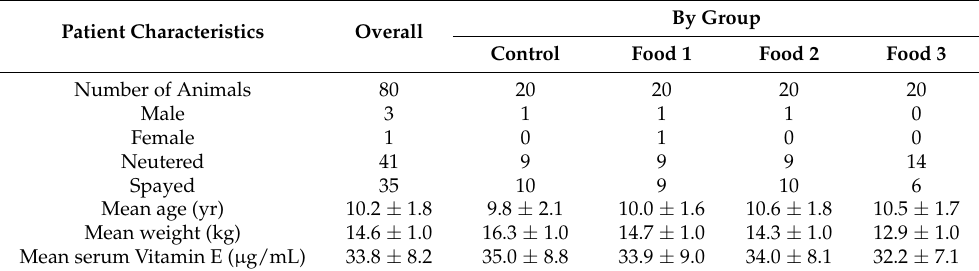
Table 1. Patient characteristics at the study start for each group. Data are represented as absolute counts or as average ± standard deviation. (Control, Food 1, Food 2 and Food 3 have 0 ppm, 75 ppm, 150 ppm and 300 ppm of a-LA